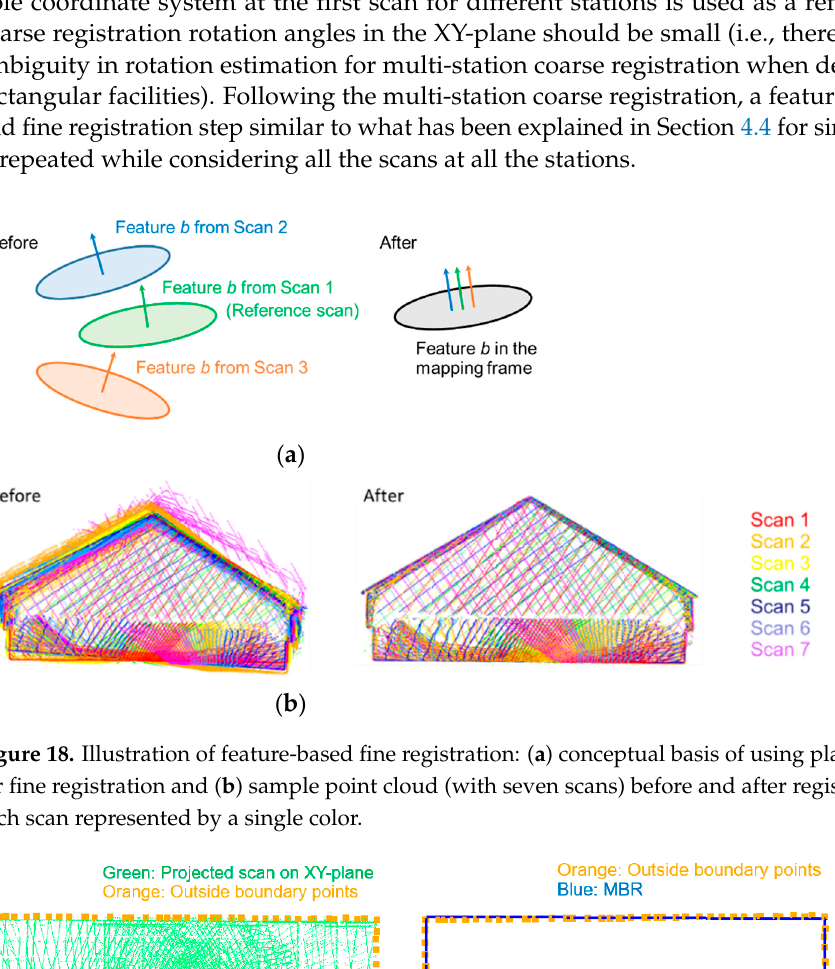
Figure 18. Illustration of feature-based fine registration: ( a ) conceptual basis of using planar features for fine registration and ( b ) sample point cloud (with seven scans) before and after registration with each scan represented by a single color.